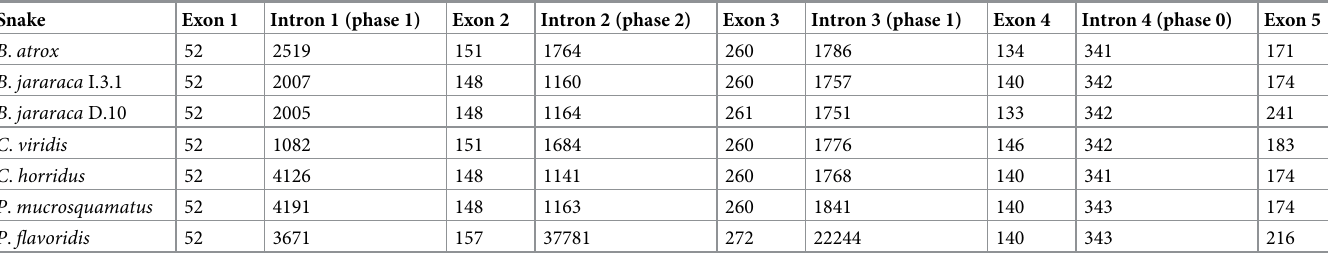
The sizes of exons and introns are informed in nucleotides, and the phases of introns are indicated in parentheses. The intron 1 of Crotalus horridus has 958 undefined